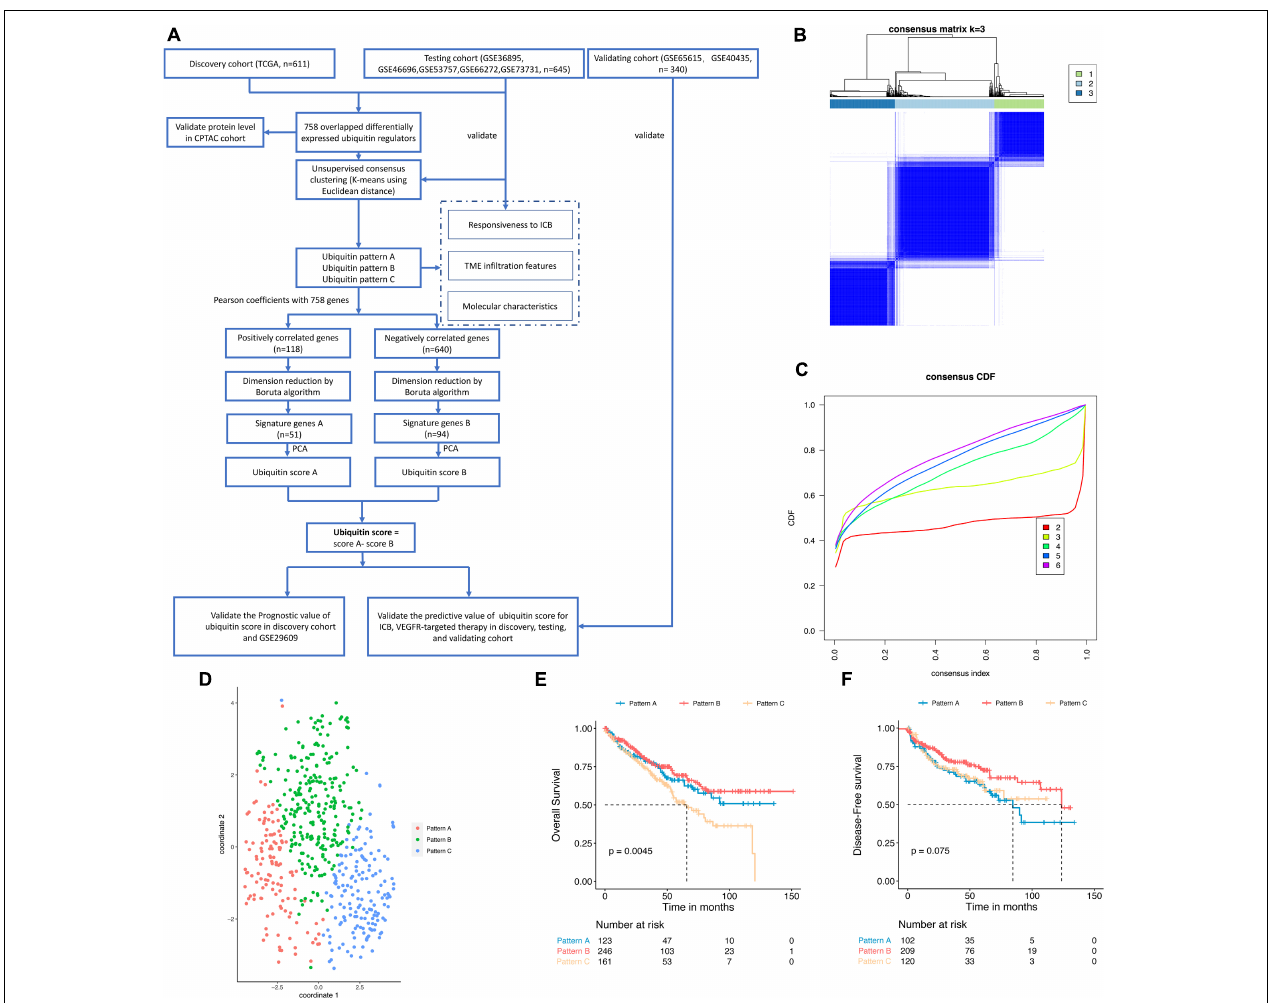
FIGURE 1 | Identification of ubiquitin patterns using unsupervised consensus clustering and prognosis analysis in the discovery cohort. (A) The workflow of this study. (B) K-means clustering using 758 differentially expressed ubiquitin regulators. (C) CDF curve of the clustering result. (D) Validating the discrimination of k = 3 using t-SNE analysis. (E,F) Overall Survival (OS) and Disease-Free Survival (DFS) of the ubiquitin patterns in the TCGA-KIRC dataset. Statistical difference was compared using the log-rank